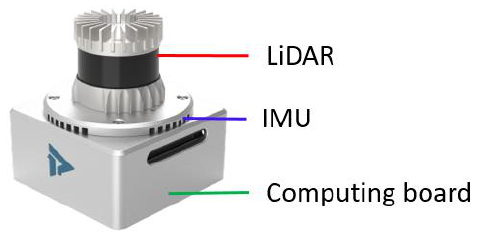
Figure 2. Configuration of multi-sensor